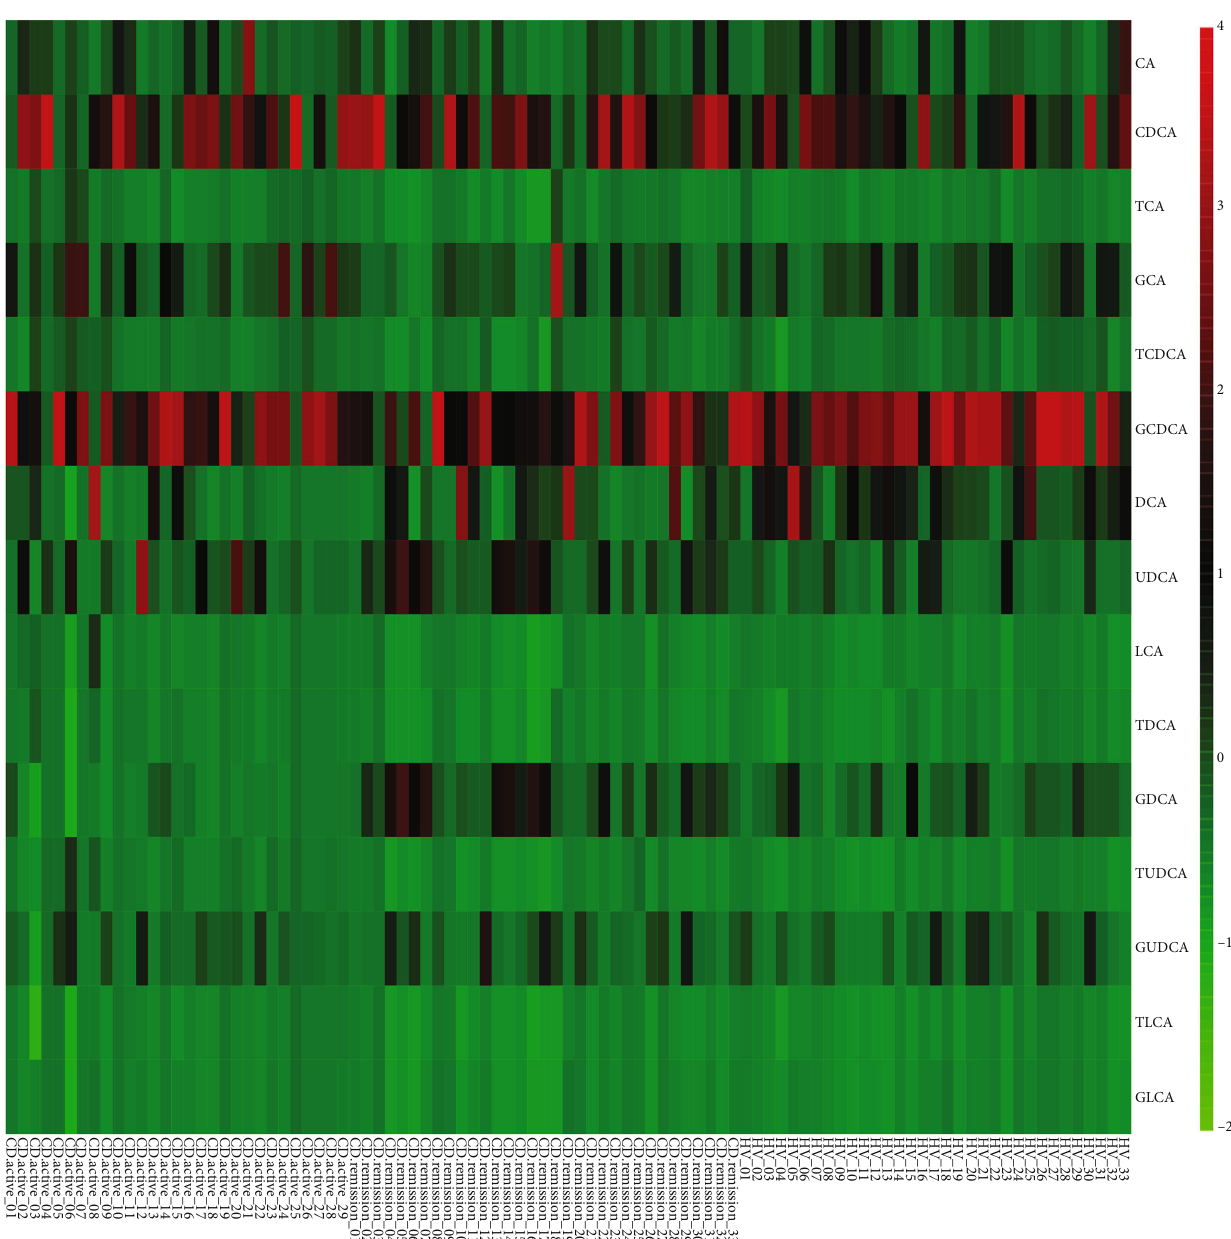
Figure 2: A heatmap analysis of serum metabolites among all participants. Groups were shown at the bottom of the fi gure as CD active ( n = 29 ), CD remission ( n = 33 ), and HVs ( n = 33 ). Green indicates a lower level than the average and red indicates a higher level than the average. Gradient changes of bile acids are re fl ected through colors in the